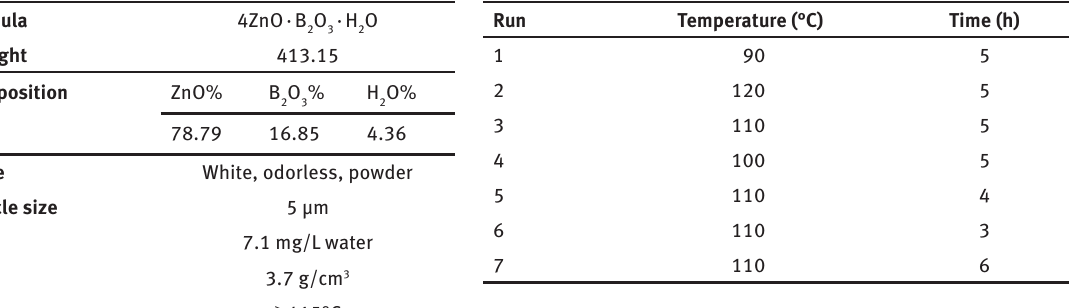
Table 3: Experimental conditions of zinc borate production Table 2: Physical and chemical properties of zinc borate